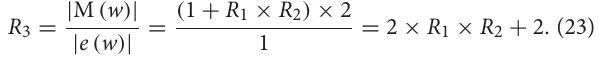
Algorithm 2 recapitulates the pseudocode of our 18-way DA, which sets R 1 = 9 to yield an 18-way DA.